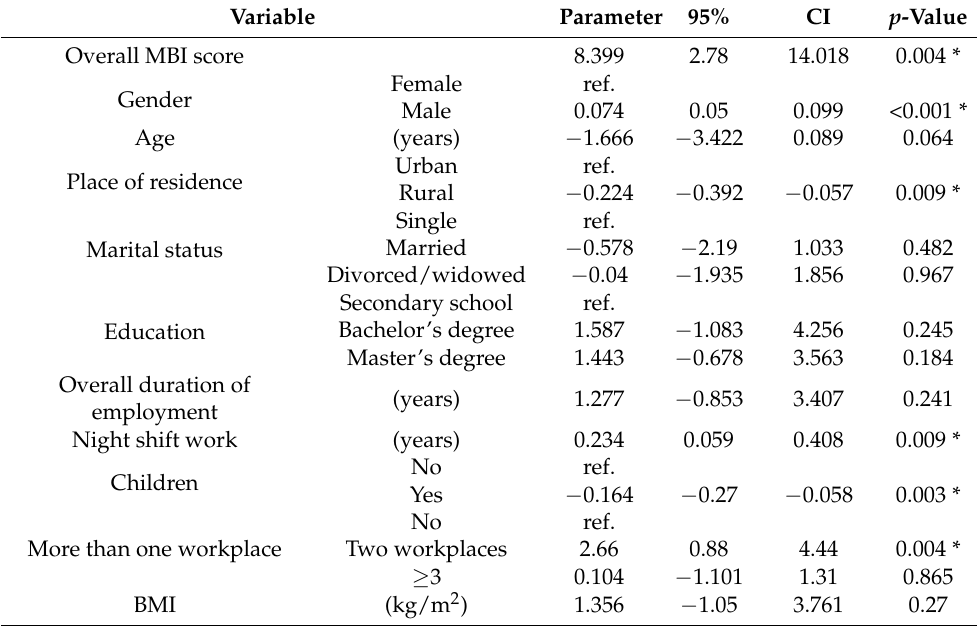
Table A3. The multifactorial linear regression of the Epworth Sleepiness Scale